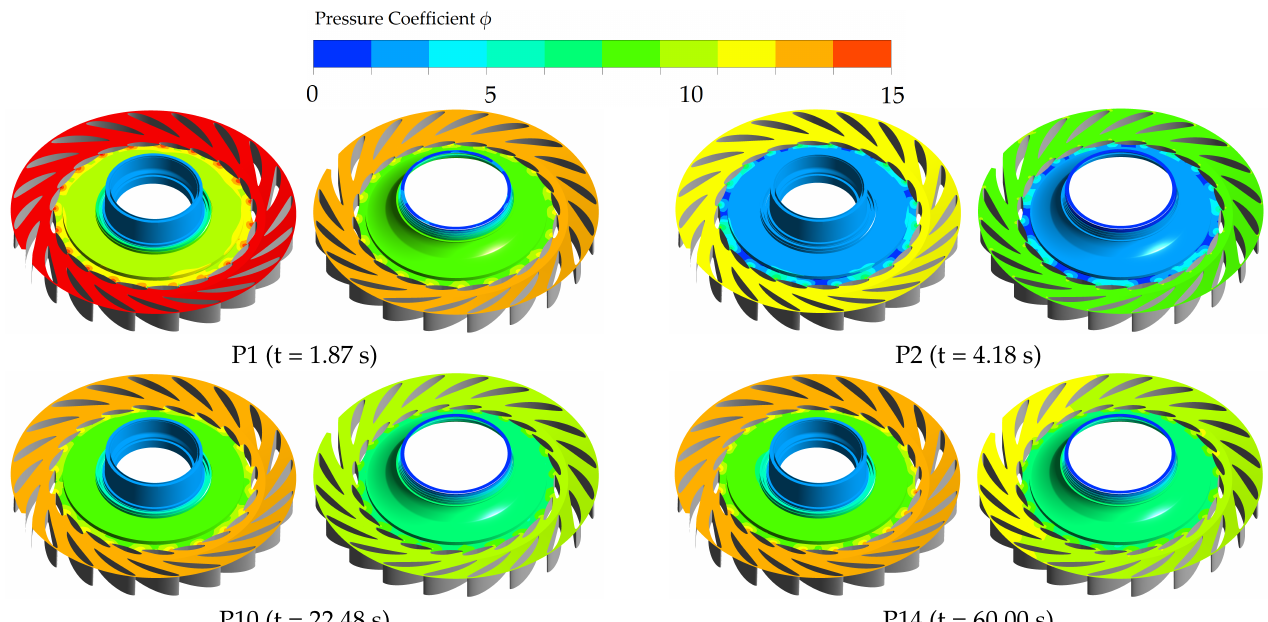
Figure 8. Pressure distribution of the pump-turbine unit during turbine start-up.